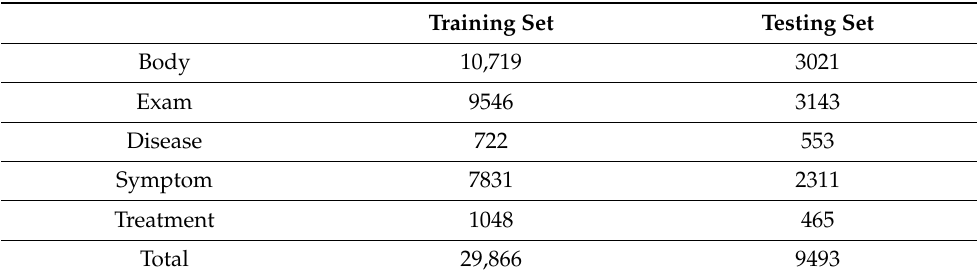
Table 2. Statistics of named entities for training/testing sets on CCKS